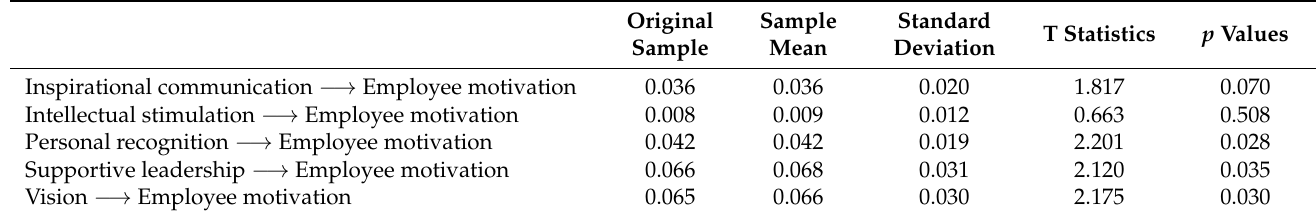
Table 9. The indirect effect among the dimensions of transformation leadership and employee